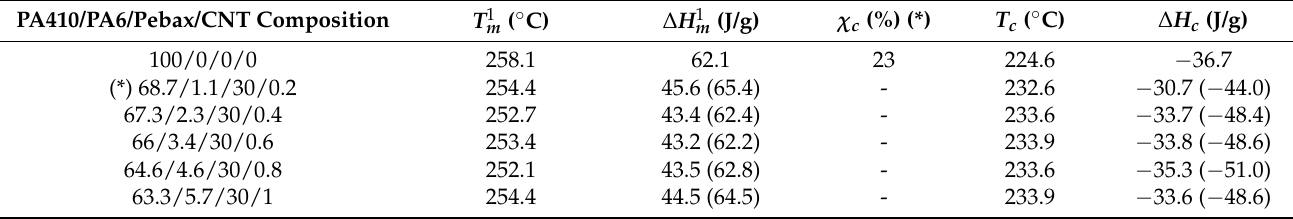
Table 4. Calorimetric parameters of the PA410/PA6/Pebax/CNT NCs. 1 First heating scan. Values in brackets are normalized with respect to the weight fraction of the polyamide